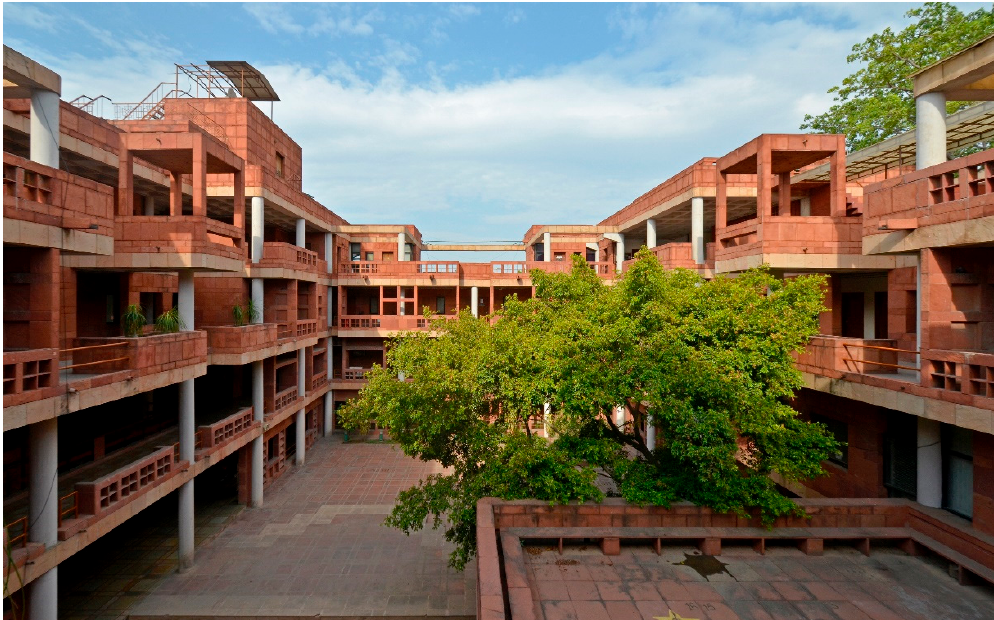
Figure 11. Central courtyard in the CIET building (Photo: Author).